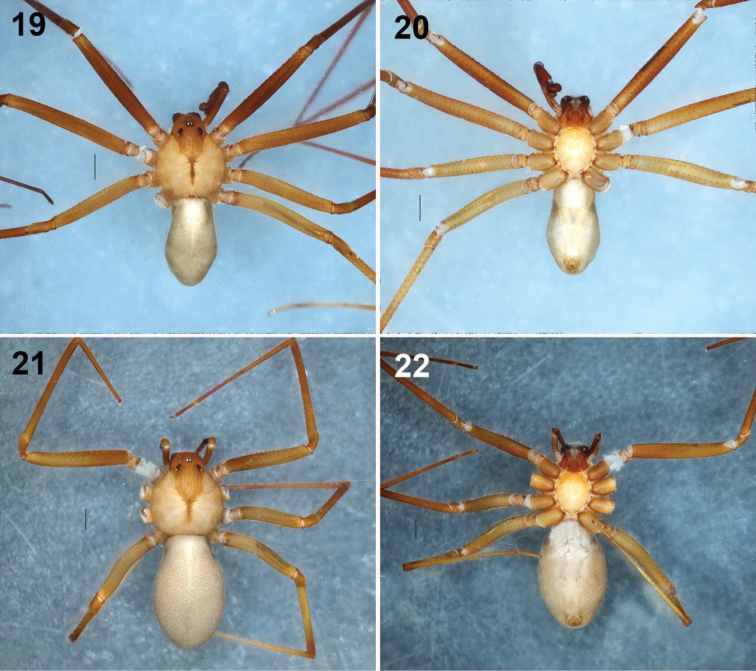
Loxosceles
tenochtitlan sp. nov 19–20 habitus of male holotype, dorsal and ventral views, respectively 21–22 habitus of female paratype, dorsal and ventral views, respectively. Scale bars: 1 mm.